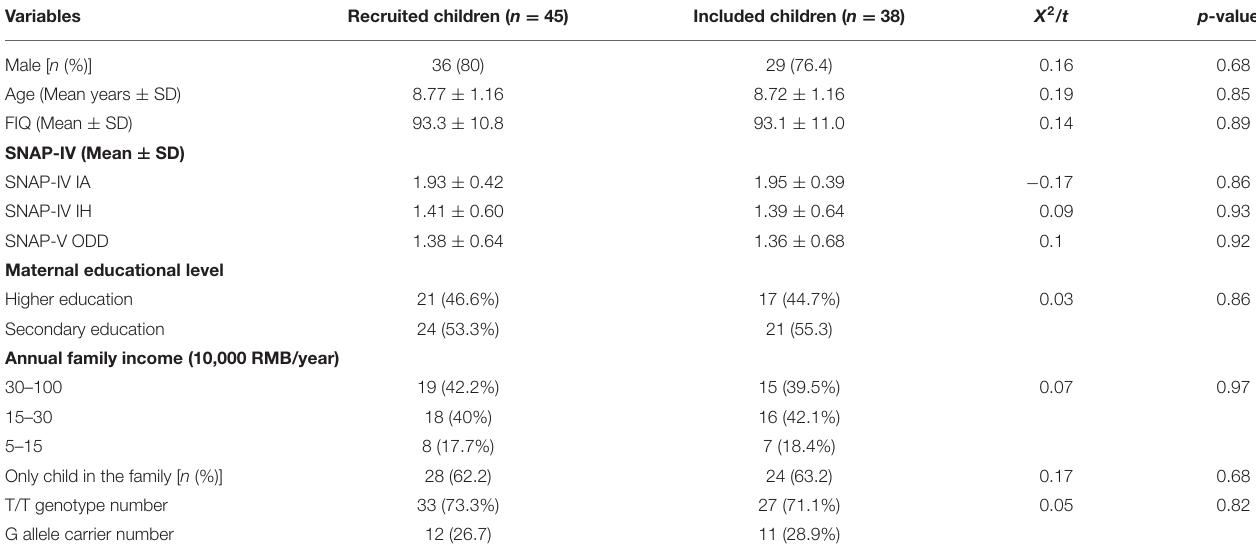
TABLE 1 | Demographic and clinical characteristics of 45 recruited children and 38 included children with attention-deficit hyperactivity disorder.